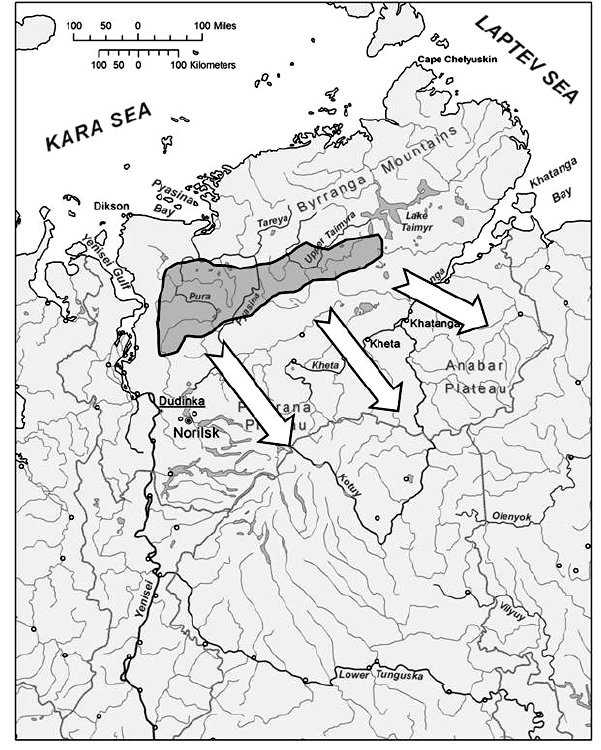
Fig. 1 . The Taimyr wild reindeer range, central Russia, showing calving areas (grey polygon) and fall migration corridors (arrows). Map adapted from basemap supplied by Anna Pestereva (ARCSES Lab, University of Northern